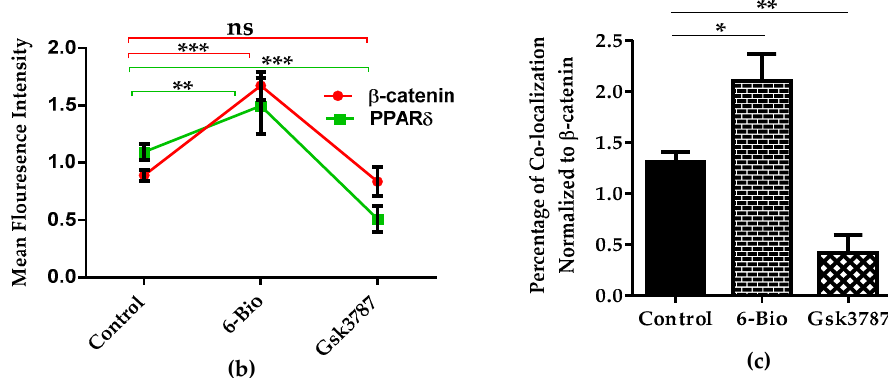
Figure 7. PPAR δ co-localizes with β -catenin upon Wnt stimulation to regulate bovine embryonic development. (a) Immunofluorescence imaging showing co-localization between PPAR δ (green) and β -catenin (red) is strengthened upon Wnt stimulation. Arrows indicate overlapping of PPAR δ with β -catenin expression merge in (yellow). Nuclei counterstained with DAPI (blue). Higher magnification of the box regions shown at the bottom (b-c) . Bar graph represents the quantification of mean fluorescence intensities and percentage of co-localization of PPAR δ with β -catenin . All data are mean ± SEM from three individual sets of experiments (n = 20 BLs). * p < 0.05; ** p < 0.01; *** p < 0.001 indicates significant difference. Original magnification 100×.